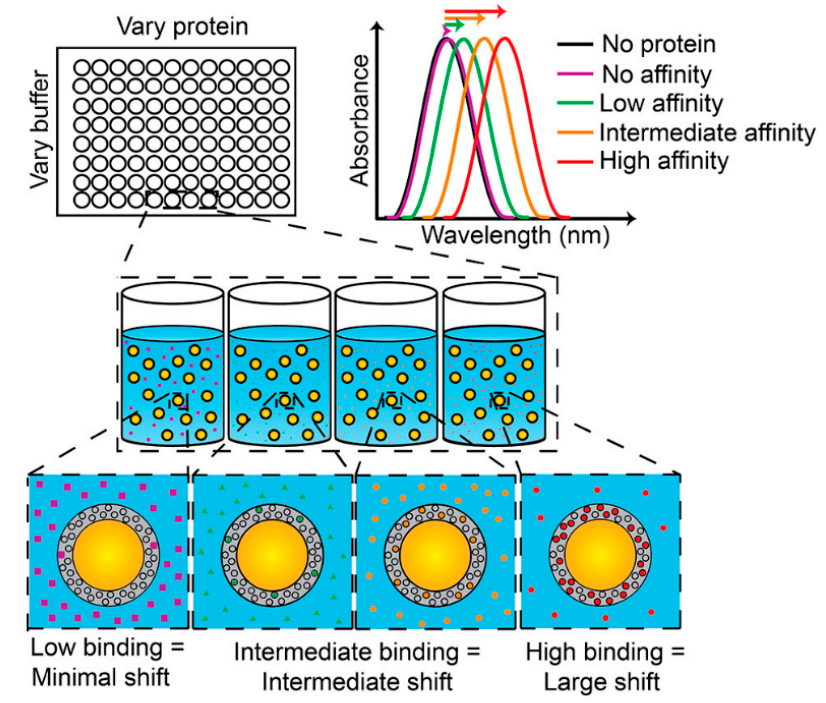
Figure 10. Scheme of the LSPR biosensor based on hydrogel-coated silica core-gold nanoshells. The shift in LSPR depends on protein concentration and affinity for the recognition units. (Reprinted with permission of [88] Copyright © 2018, American Chemical Society).